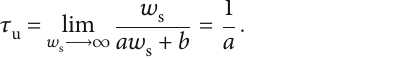
Table 2: Selected test factors. Normal